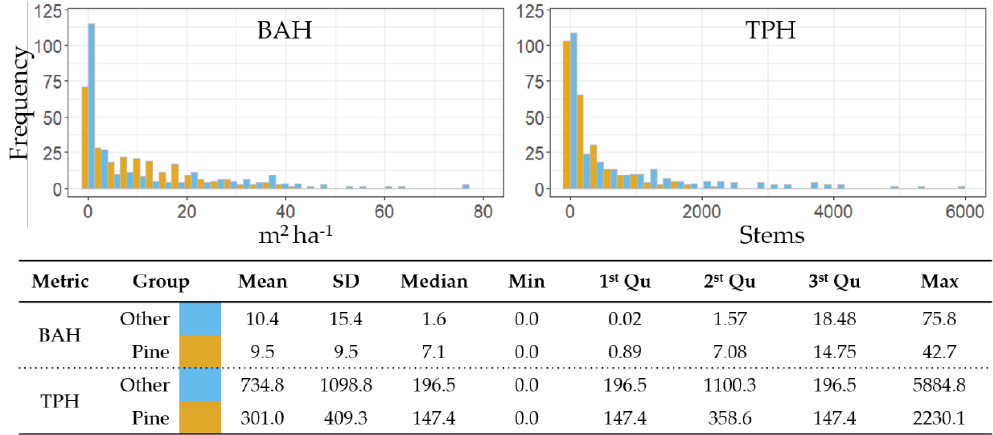
Figure 4. Histograms and summary statistics of plot basal area m 2 ha − 1 (BAH) and trees ha − 1 (TPH) for pine and other tree species groups.